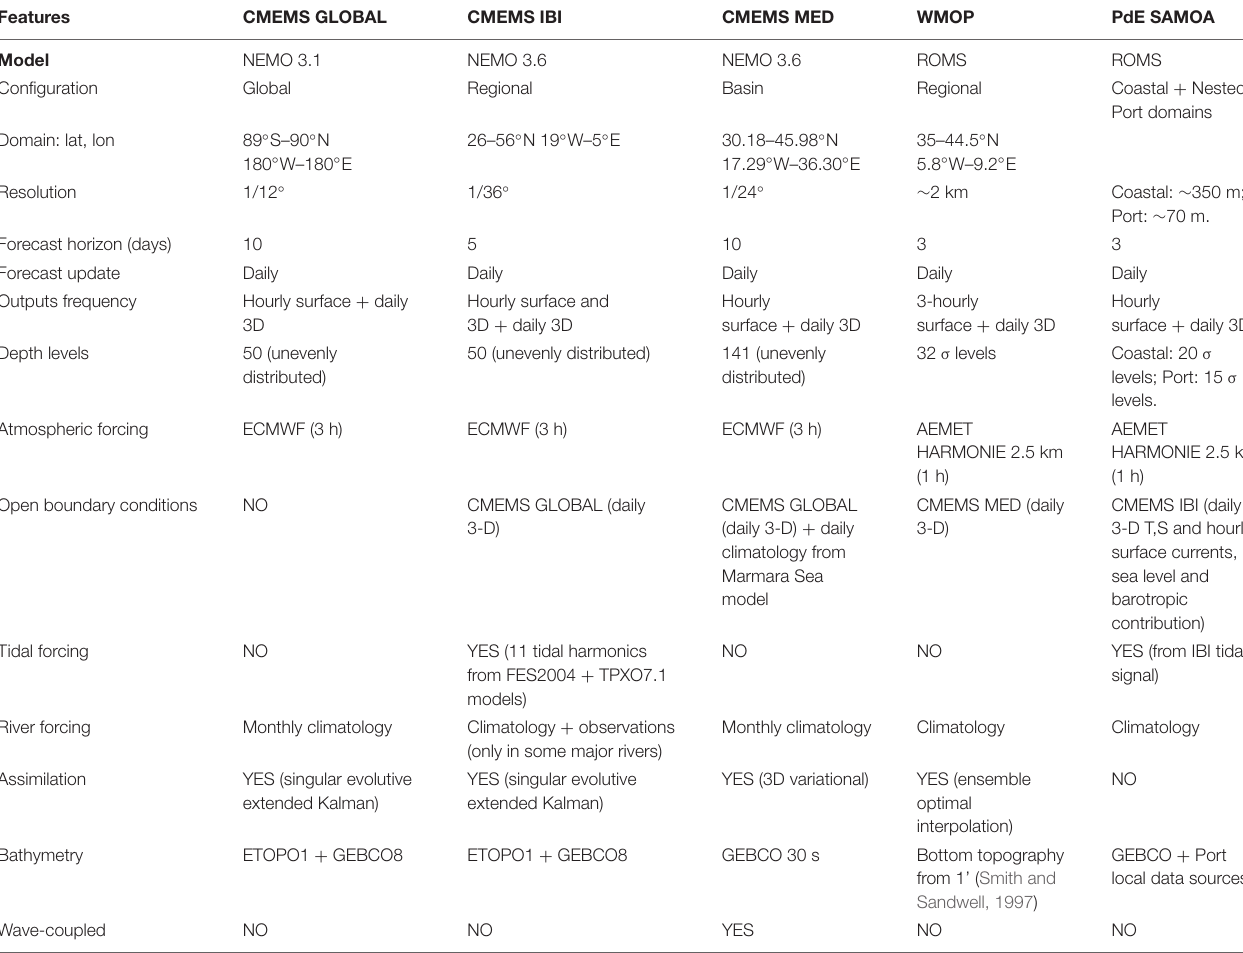
TABLE 1 | Basic features of the five different ocean forecast systems employed in the present study.